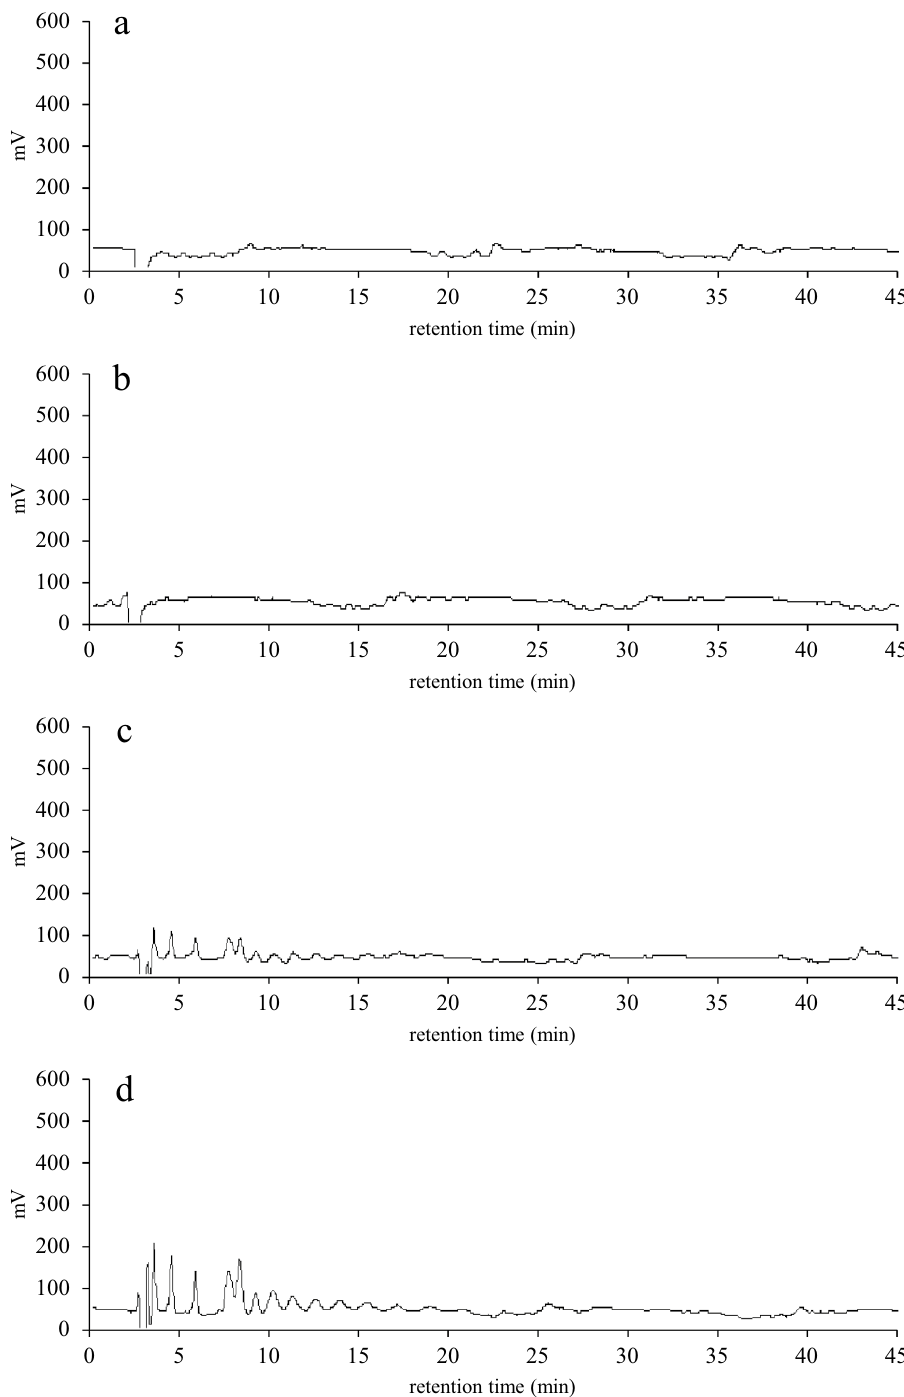
Figure 4. Comparison of intracellular inulin of B. subtilis 168 and UT02 (Ldb1381-1386-introduced 168 strain) cells. The cells prepared as described in Fig. 3 were lysed and disrupted by sonication, and intracellular inulin polymers in the supernatants were analyzed by HPLC. Inulin elution patterns for 2 h-incubation of B. subtilis 168 cells ( a ) and 0.5 ( b ), 1 (c), and 2 (d) h-incubation of UT02 cells are